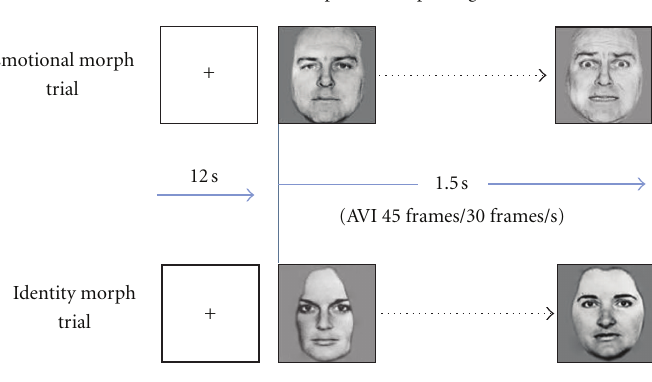
Figure 1: fMRI task